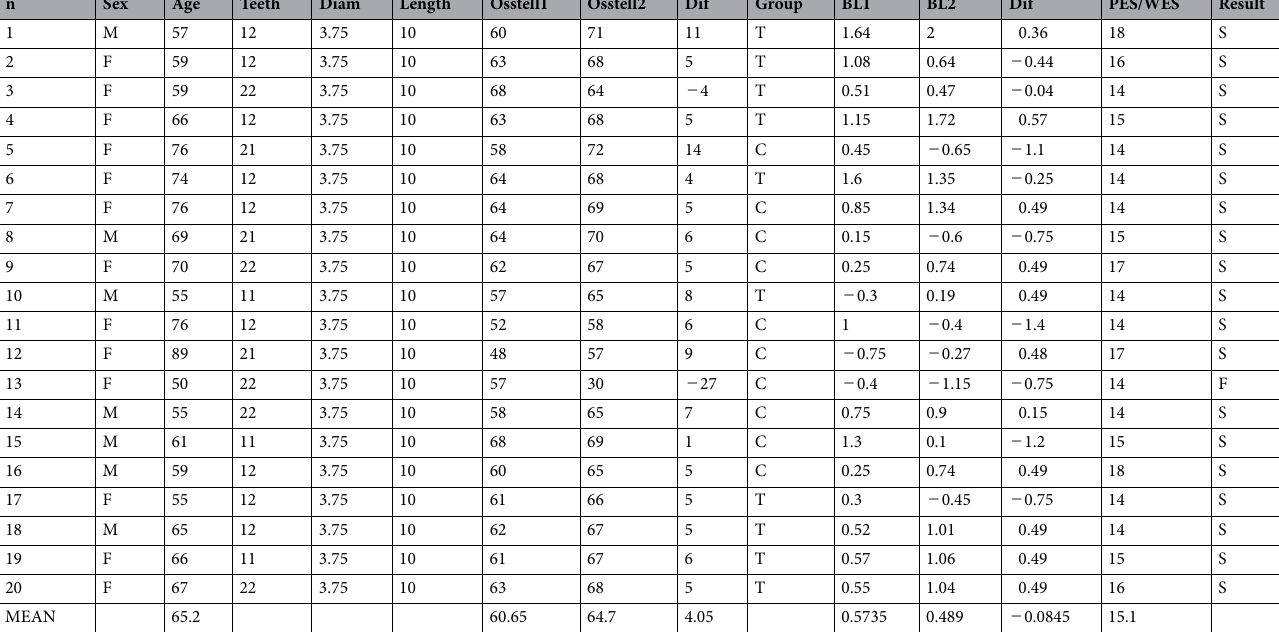
Table 2. Detailed description of the sample description and data obtained, being n: number of patient; Sex: male (M)/female (F); Age: age in years; Teeth: Teeth position; Diam: Implant diameter; Length: Implant length; Osstell 1: osstell measurement at placement; Osstell 2: osstell measurement before placing the definitive prosthesis; Dif: Difference between both osstell measurements; Group: T (treatment)/C (control); BL1 (bone level measurement in mm. at loading); BL2 (bone level measurement in mm. at 12-months post-loading); Dif: Difference between both bone level measurements; PES/WES: PES/WES score obtained; Result: Success (S)/ Failure